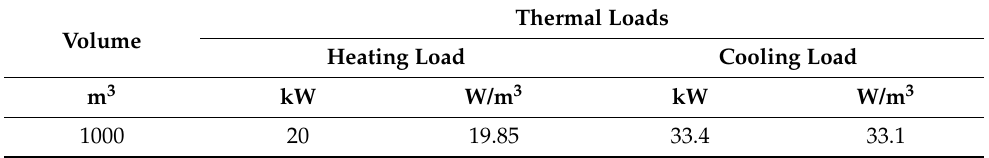
Table 2. Thermal loads of the